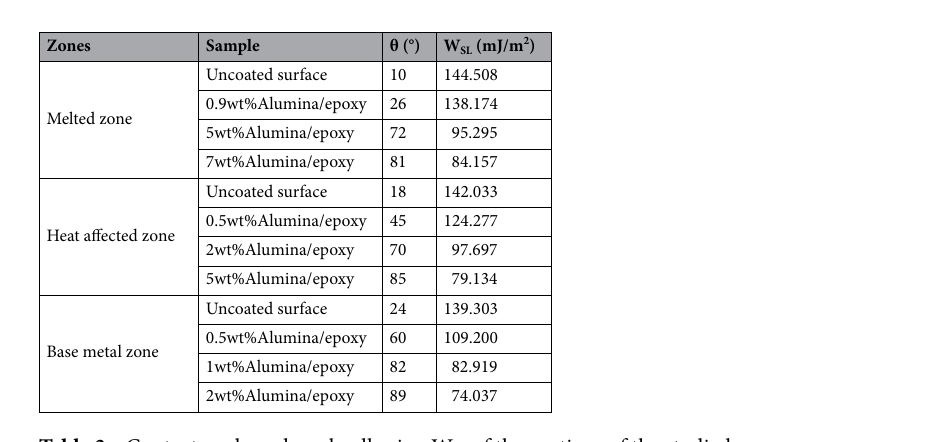
Table 3. Contact angle and work adhesion W SL of the coatings of the studied